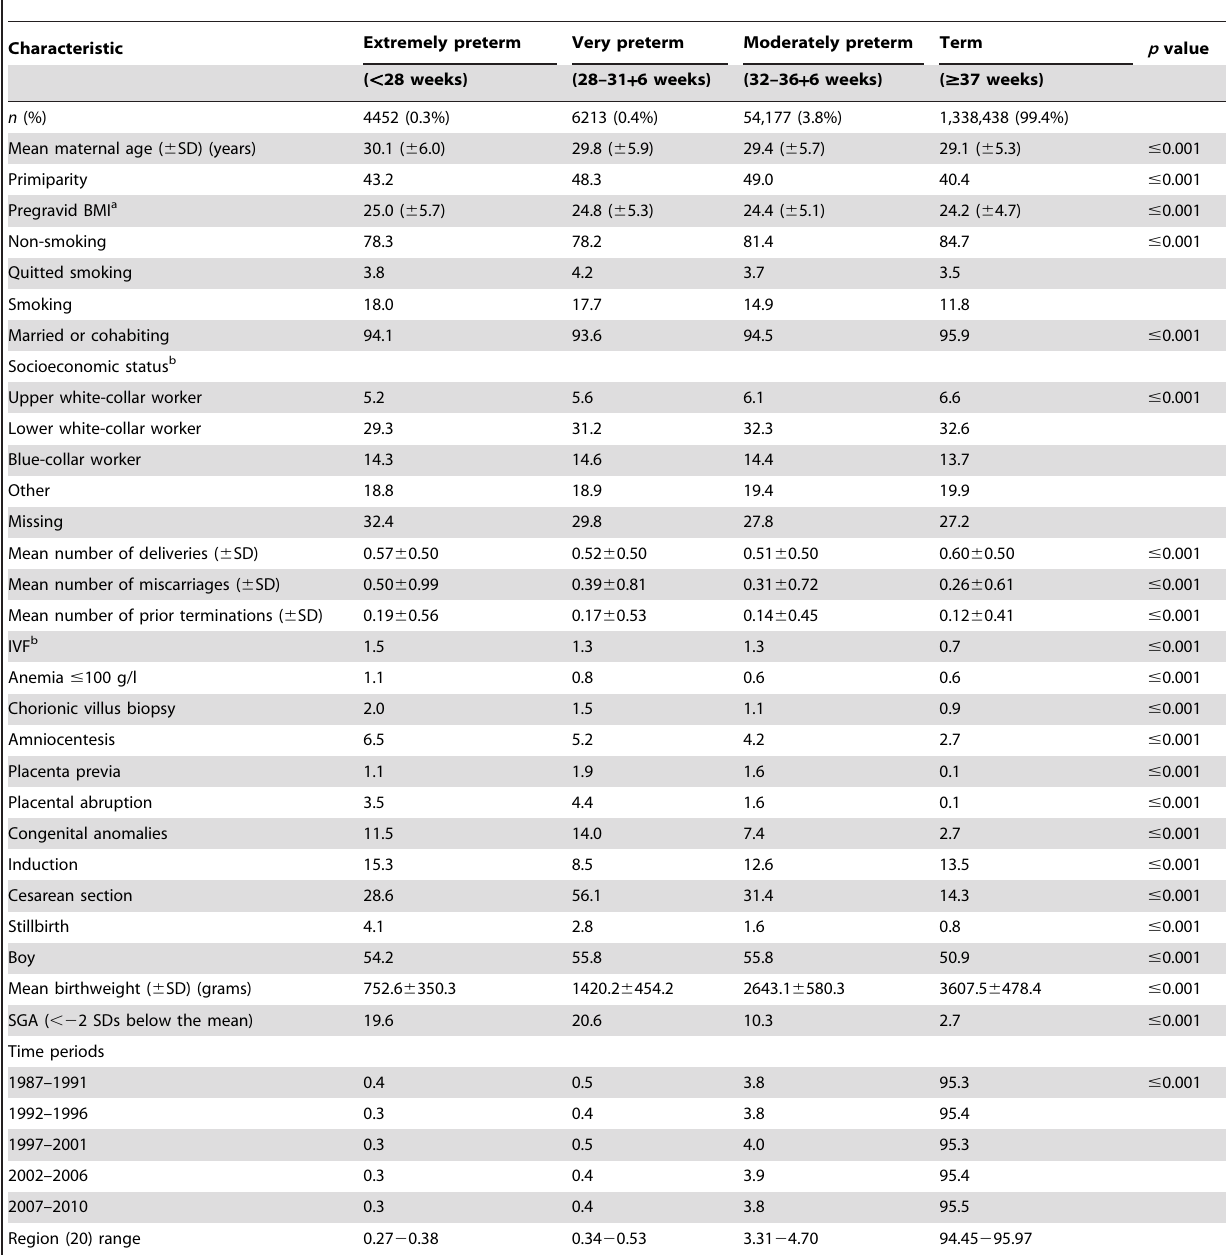
Table 1. Demographic characteristics and reproductive risk factors among each singleton preterm birth group and term births ( n =1,390,742) for the years 1987–2010 in